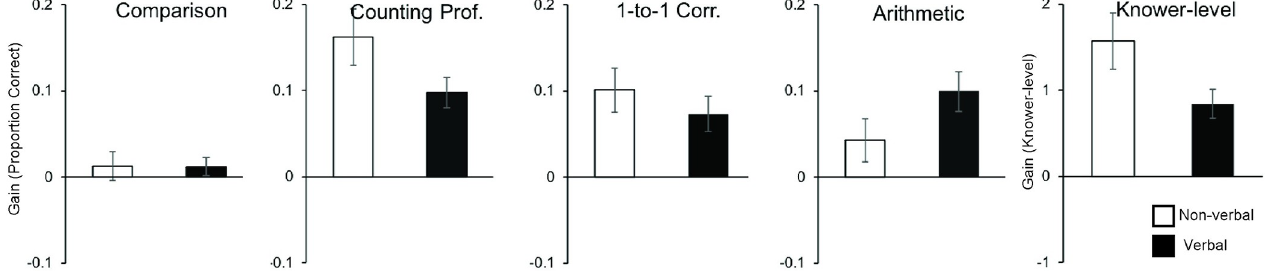
Fig 4. Mean gains in numeracy after numerical comparison training with symbolic verbal or symbolic non-verbal aids. Error bars are -/+ 1 SE. Note that gains themselves were significantly different from zero in all areas except numerical comparison, but the differences between verbal and non-verbal symbols on numerical comparison, counting proficiency, one-to-one correspondence, and arithmetic were not significant. A moderate advantage for the non-verbal symbolic aid (abacus) on knower-level.